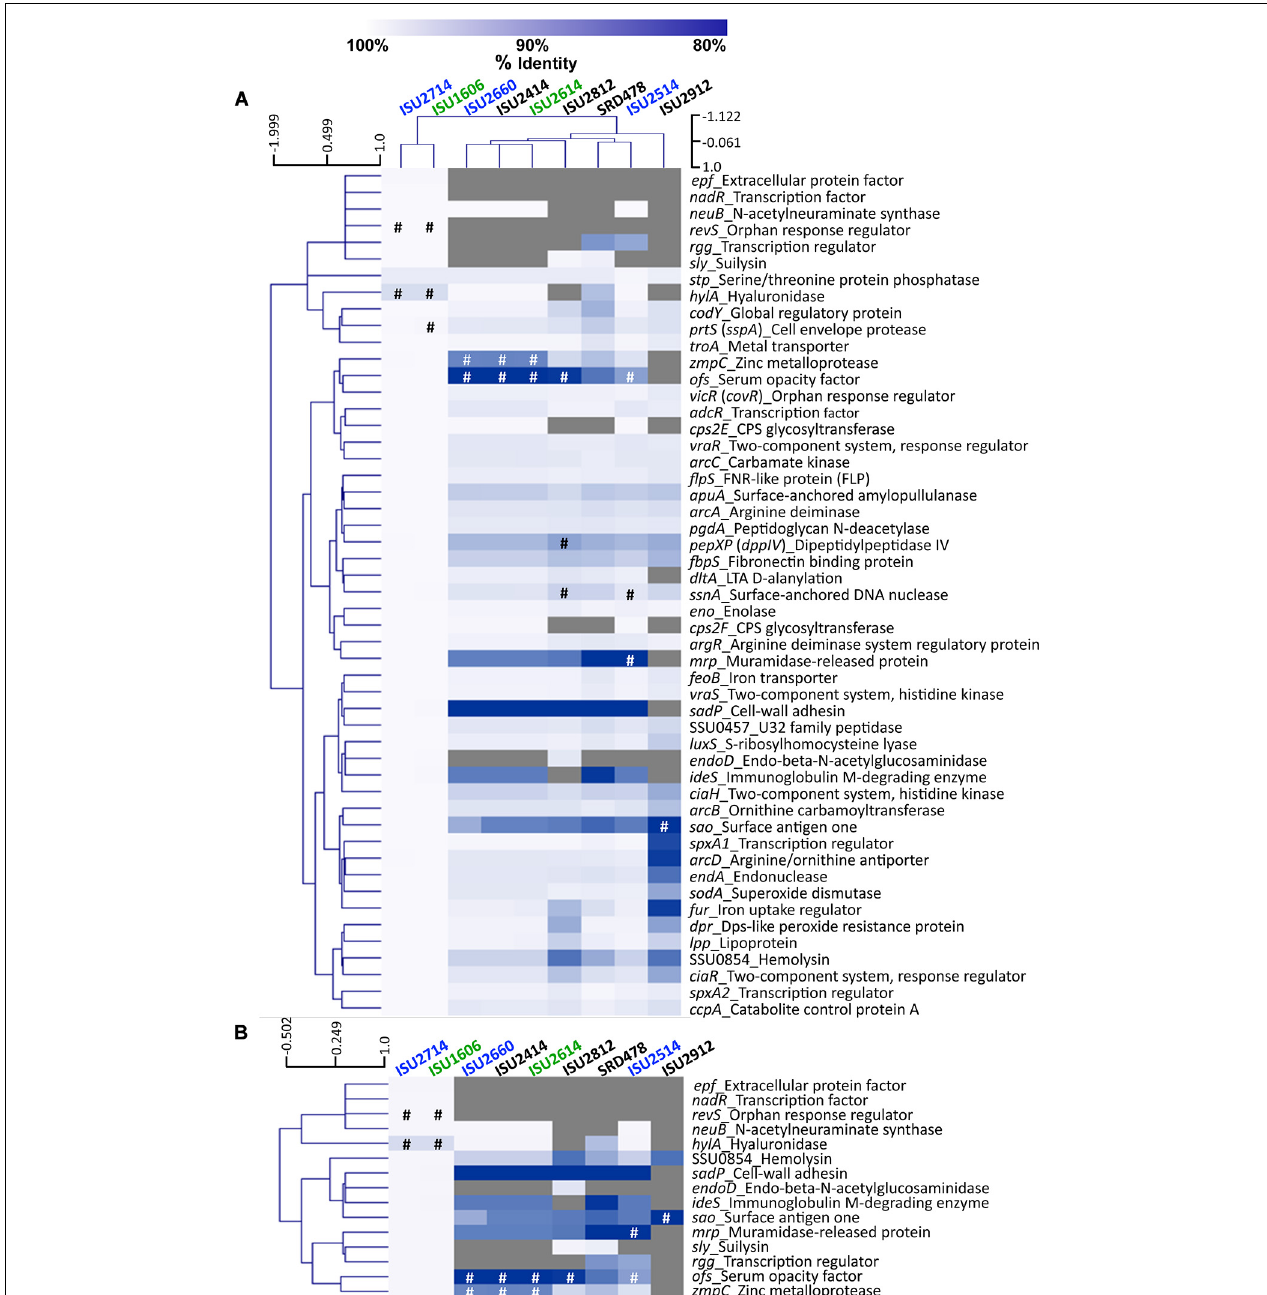
FIGURE 6 | Hierarchical cluster heatmap displaying the relatedness of S. suis isolates based on the nucleotide percent identity of analyzed virulence genes. (A) Heatmap based on nucleotide percentage identity for all analyzed virulence genes. Heatmap generated from nucleotide percentage identity was converted into a distance matrix and clustered by means of complete hierarchical clustering based on Pearson correlation distance for both genes and isolates. (B) Heatmap based on nucleotide percentage identity for selected genes with high sequence divergence. Heatmap generated from nucleotide percentage identity was converted into a distance matrix and clustered by means of complete hierarchical clustering based on Pearson correlation distance for genes only. Isolates names are provided at the top of the heat map and gene names are provided at the right side of heat map. Font color used for isolate names color reflective of virulence categorization (green: highly virulent; blue: moderately virulent; black: non-virulent). The percent identity of analyzed genes (rows) from each isolate (columns) is represented using the color scale at top, while genes not present within a strain are indicated by gray. Annotated pseudogenes are indicated by # (white or black). Dendrograms are on the left side and on top of the heat